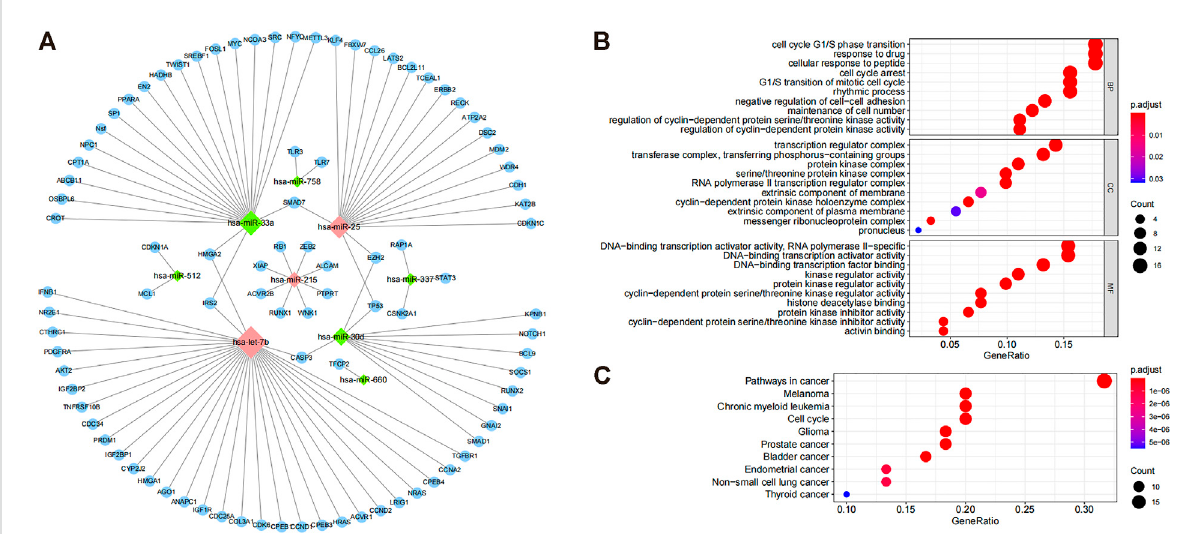
FIGURE 2 Target gene prediction of common differential miRNAs and their functional enrichment analysis. (A) Differential regulation of miRNAs. The diamond-shaped dots indicate miRNAs. Green and red dots indicate downregulation and upregulation, respectively, and blue dots indicate